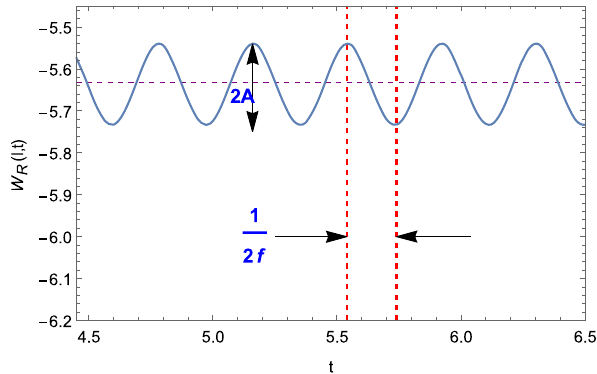
cases. The static potentials are − 11.8713 and − 5.6318. The amplitude of oscillation is 2 A = 0 . 0447 for the left panel and 2 A = 0 . 1869 for right one